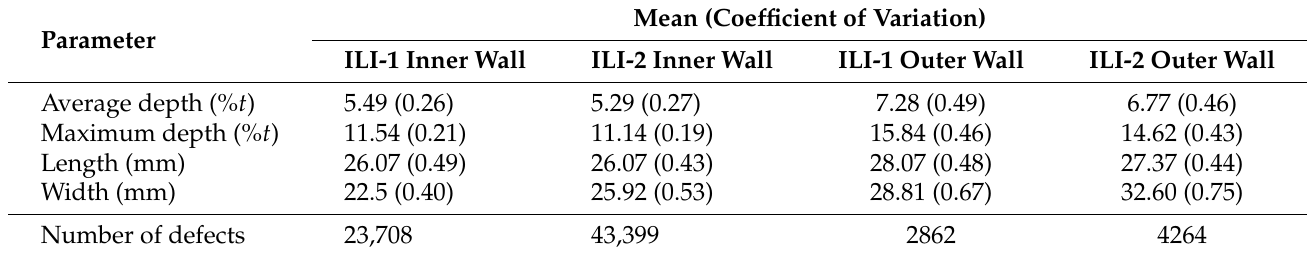
Table 4. Summary of corrosion defects along the